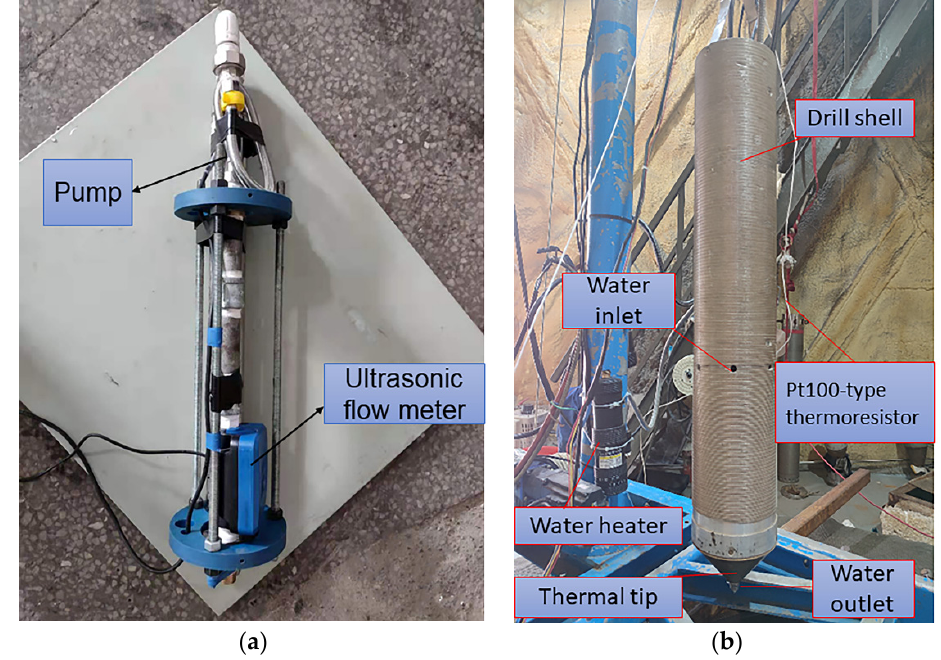
Figure 2. The internal ( a ) and external ( b ) structures of the drill assembly.